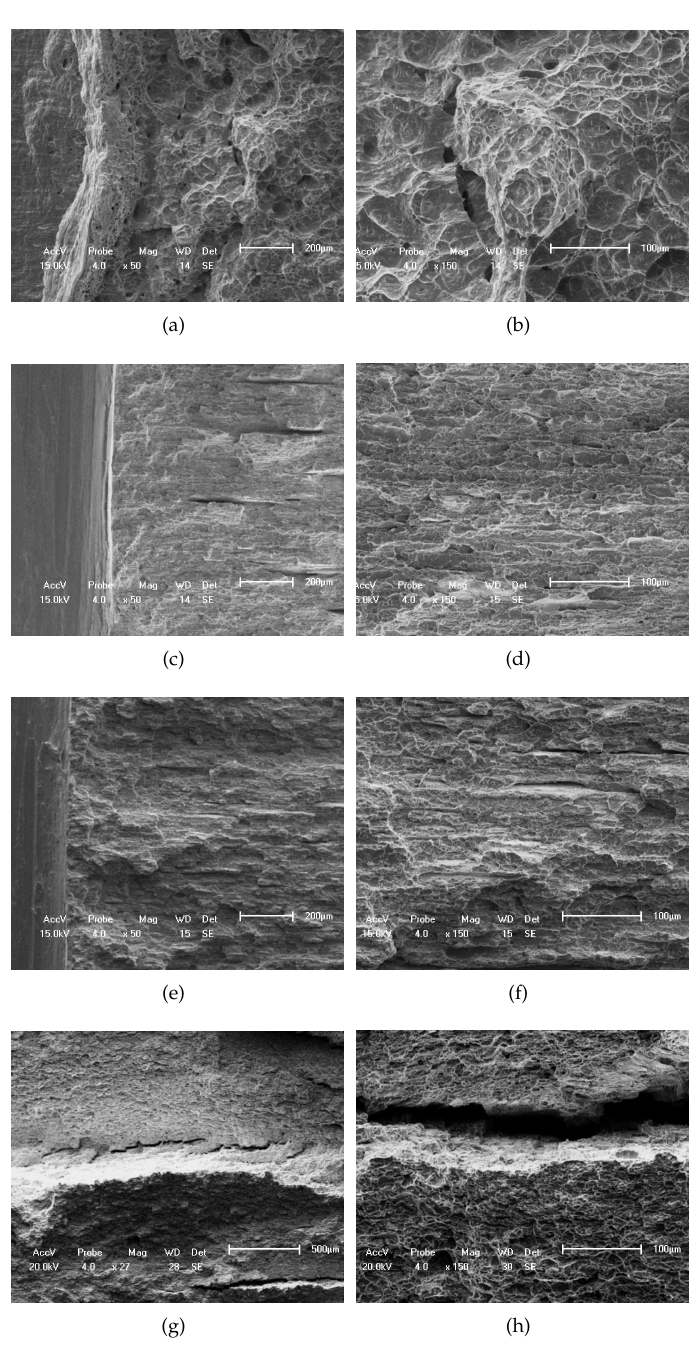
Figure 4. Fracture surface microstructures of the samples with different contents of sigma phase: ( a ) 2.24%; predominantly ductile fracture; ( b ) 2.24%, existence of some cracks; ( c ) 2.84%, presence of cracks; ( d ) 2.84%, transgranular and intergranular regions; ( e ) 7.5%, brittle surface with delamination; ( f ) 7.5%, detail of the delamination; ( g ) 18%, brittle with increased delamination; and ( h ) 18%, detail of the